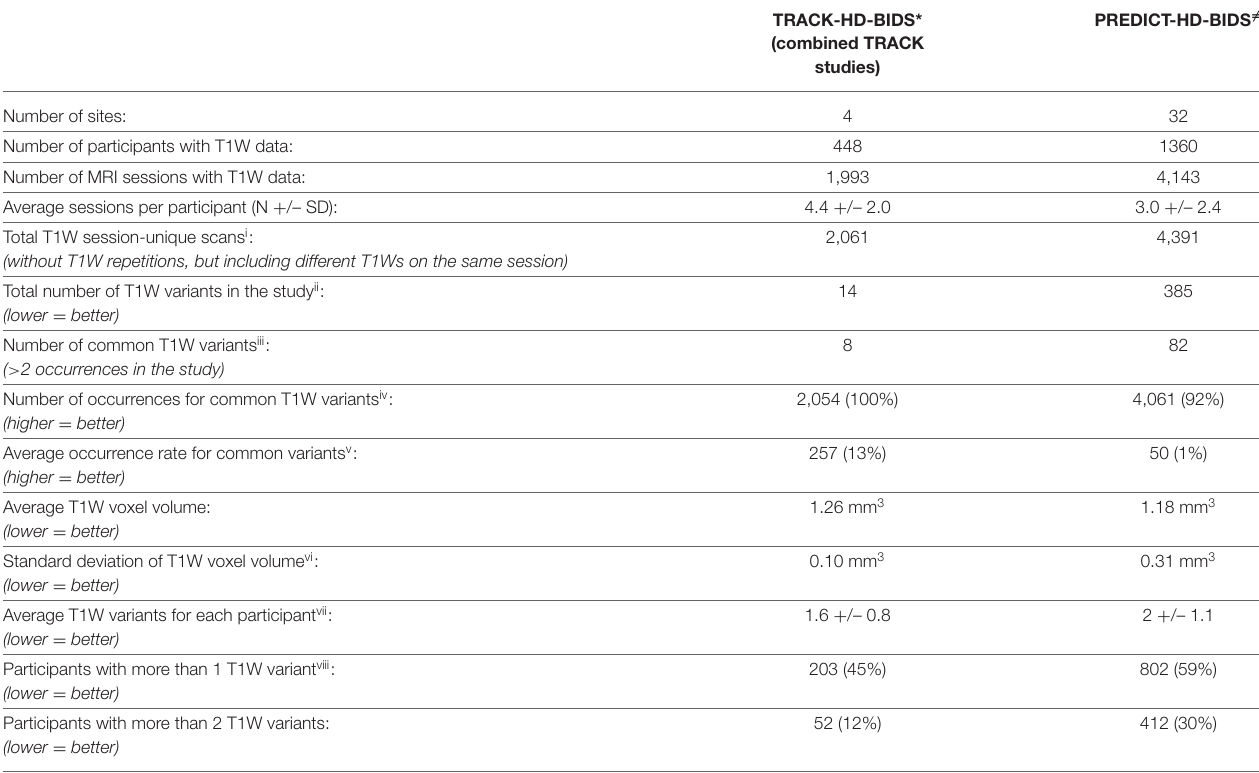
TABLE 2 | A comparison of anatomical (T1W MRI) data homogeneity in two large multi-site observational studies in HD.